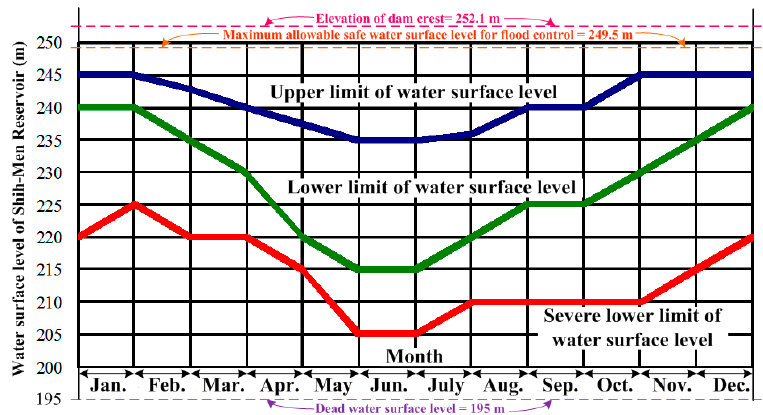
Figure 2. Hedging rule curves and characteristic elevations of Shih-Men Reservoir water surface level (WSL).